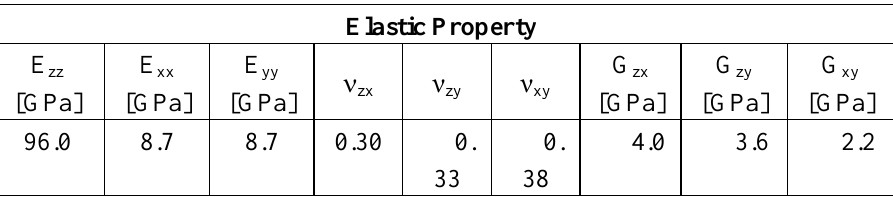
Table 1. Composite elastic